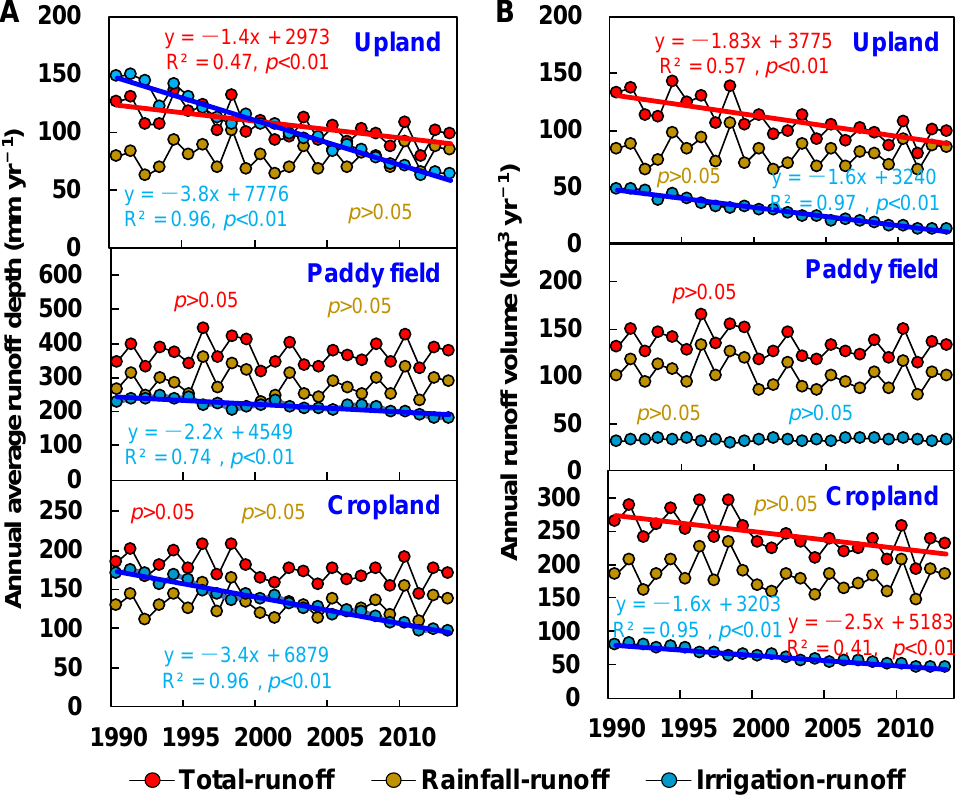
Figure 5. Temporal trends of national cropland ( A ) runoff depth and ( B ) runoff volume during 1990–2013 in China. Rainfall-runoff volume was equal to the product of rainfall-runoff depth and cultivated land area; irrigation-runoff volume is equal to the product of rainfall-runoff depth and irrigated land area.